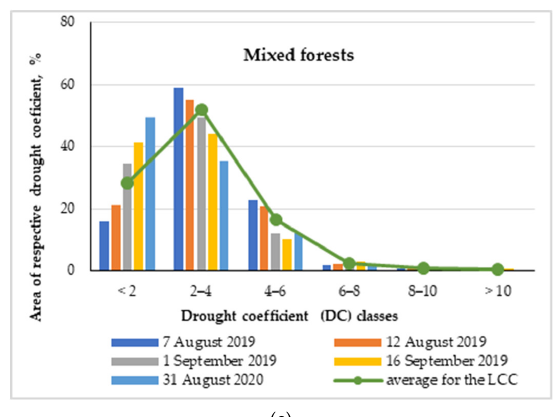
Figure 4. Distributions of Drought coefficient (DC) for the individual land cover classes (LCC) at the studied dates; ( a ) pastures and natural grasslands; ( b ) transitional woodlands/shrubs; ( c ) broadleaved forests; ( d ) coniferous forests; ( e ) mixed forests.